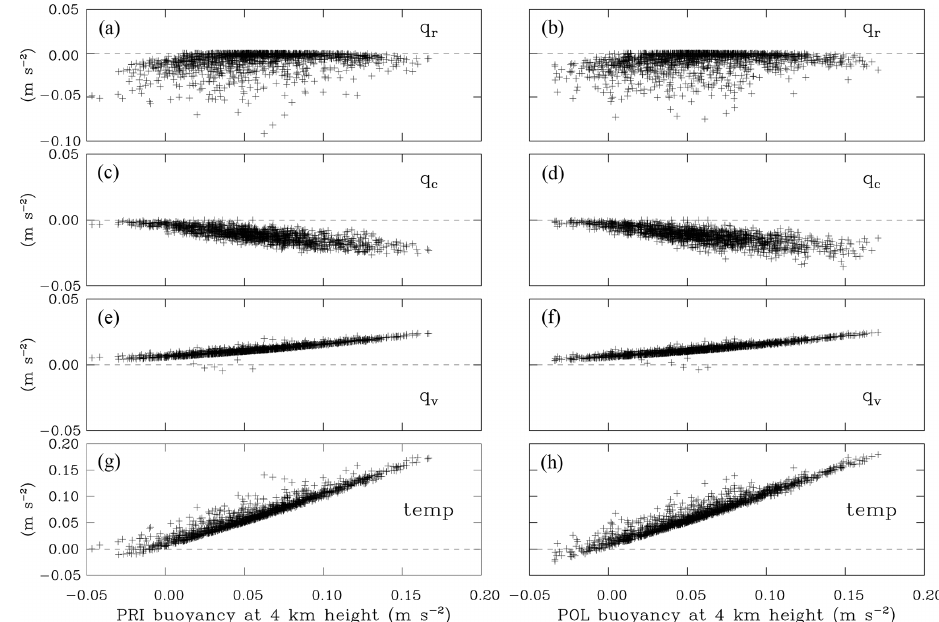
Figure 8. Scatterplots of buoyancy components at 4km as a function of the total buoyancy in (a, c, e, g) PRI and (b, d, f, h) POL of all four ensemble members of IAB simulations at hours 6 and 7. The horizontal axes in both columns represent the total buoyancy. Panels (g) and (h) show the temperature buoyancy component. Panels (e) and (f) show the water vapor contribution. Panels (a) – (d) are the loading buoyancy components, separated into (c, d) cloud water and (a, b) rain components. Points with updraft larger than 1ms − 1 and total condensate larger than 1gkg − 1 are included. Only about 8% of data points are